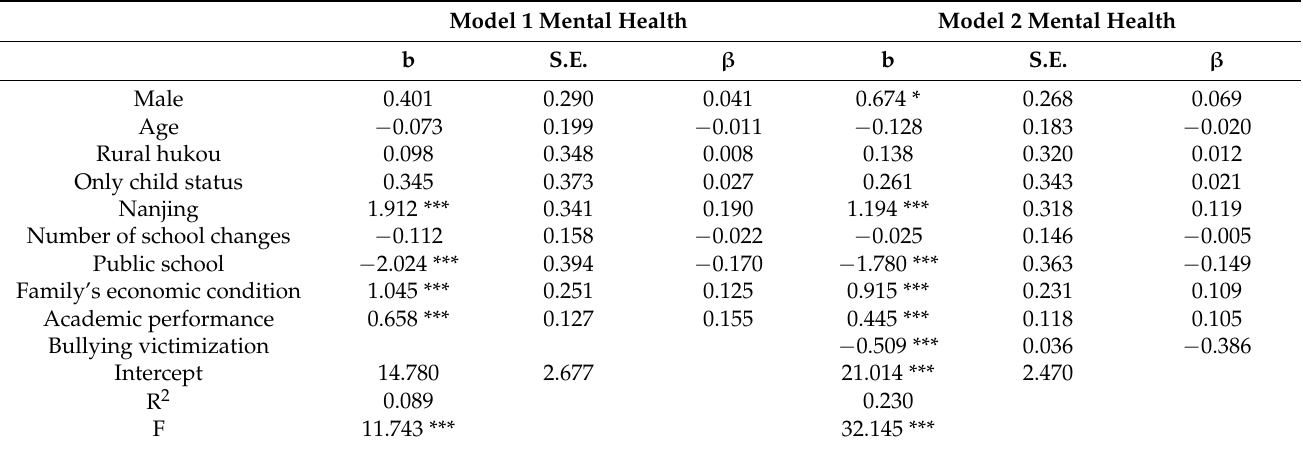
Table 3. Results of the multiple linear regression